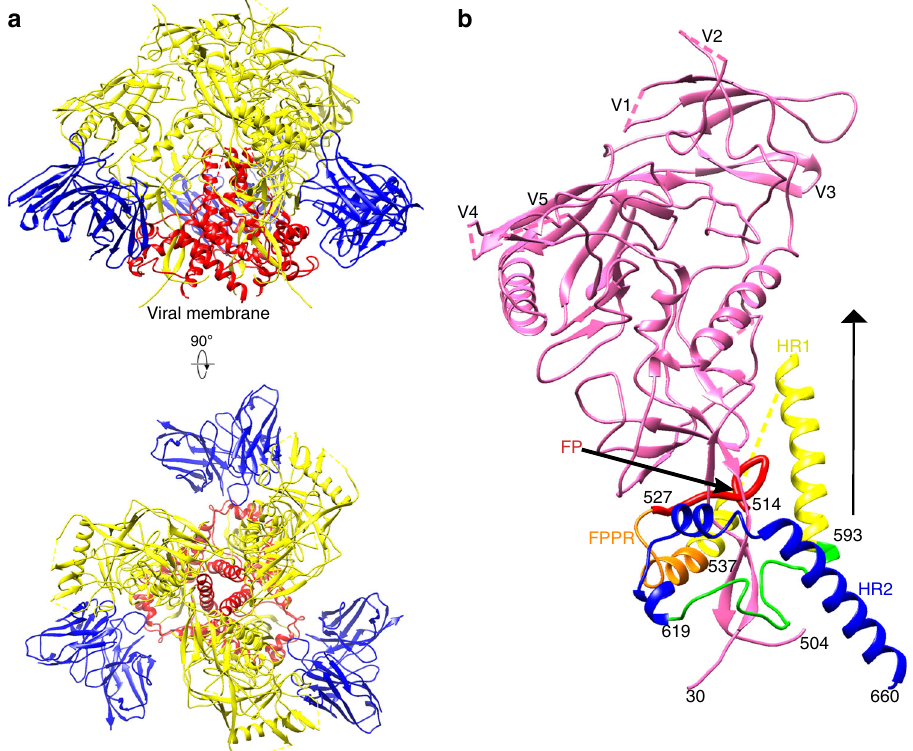
Fig. 2 Structure of the T/F100 Env trimer in complex with Fab fragments of the bNAb 8ANC195 . a Ribbon diagram of the atomic model of the T/F100 trimer in complex with the 8ANC195 Fab. Gp120, gp41, and the Fab are colored in yellow, red, and blue, respectively. Shown are the side view (top) and the view down the three-fold axis (bottom). b Ribbon diagram of a monomer of the T/F100 trimer. The three-fold axis is indicated by a black solid triangle. The fusion peptide (FP), the fusion peptide proximal region (FPPR), the heptad repeat 1 (HR1), and the heptad repeat 2 (HR2) regions of gp41 are colored red, orange, yellow, and blue, respectively. Gp120 is colored